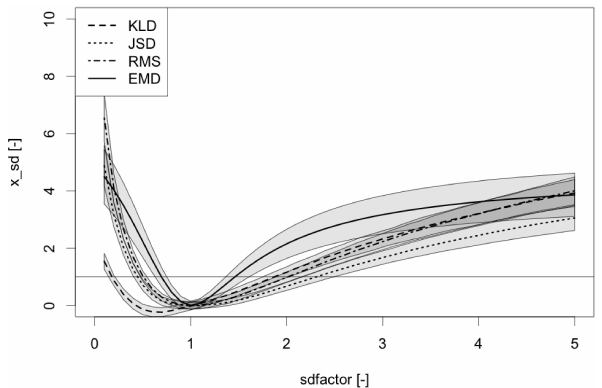
Figure 3. Results of the regime shift sensitivity test, with artificially included shifts in the variance. The shift is measured in terms of the standard deviation and shown on the x-axis. The curves shows the average and their respective uncertainties of the measure x sd in Eq. (7) for 100 randomly generated data sets (without shift normally distributed with expectation mean = 0, sd = 1) for the four di ff erent